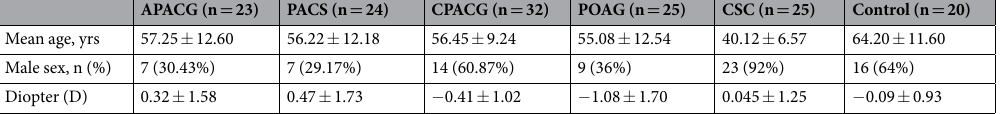
Table 1. Demographic features of study participants.